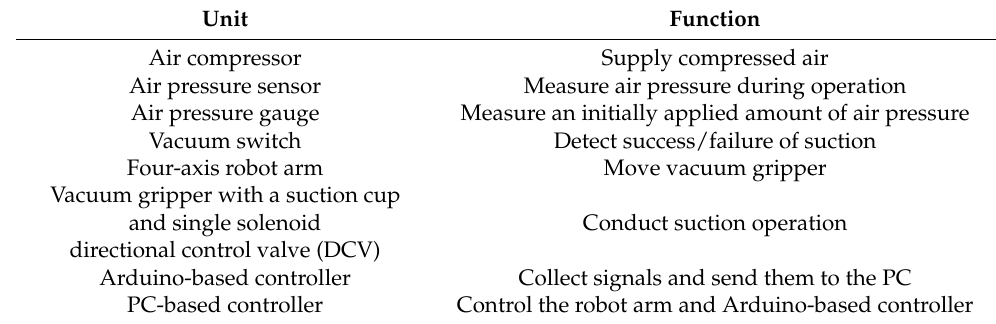
Figure 2. Testbed for performing the pick-up operation and monitoring the amount of applied air pressure during each operation cycle: ( a ) front view; ( b ) top view; ( c ) closed view for a suction cup. Table 2. Summary of testbed